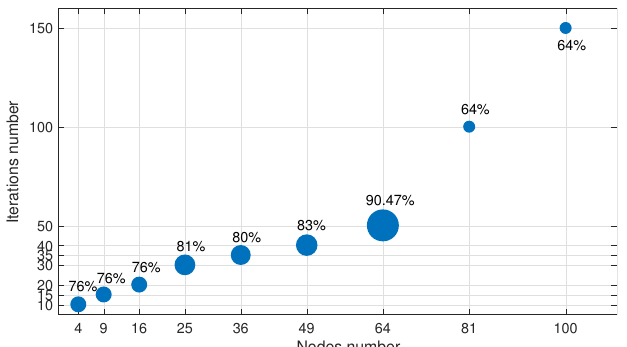
Figure 5. Variation of the recognition rate vs. the number of nodes and the number of iterations in the sample-encoding Kohonen network. The size of a circle is proportional to the classification rate it represents.